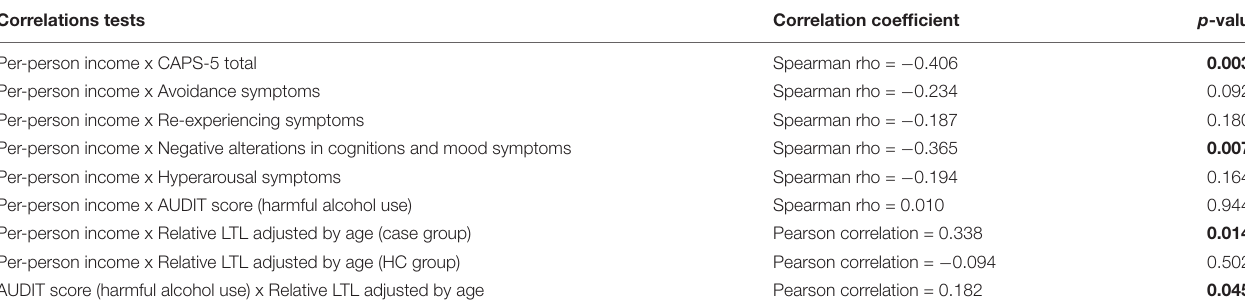
TABLE 2 | Correlation results of PTSD symptom clusters with per-person income, relative LTL adjusted by age and per-person income or alcohol consumption, and per-person income or alcohol consumption.